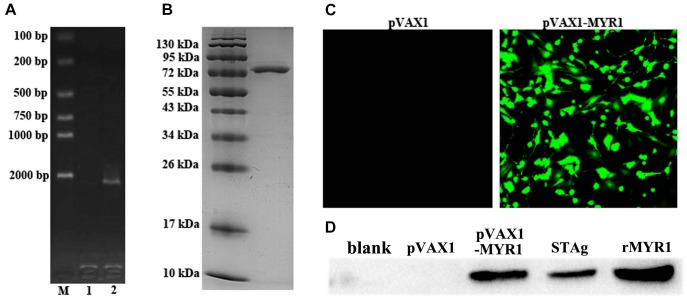
Expression of pET-28a-MYR1 in E. coli BL21 (DE3) and pVAX1-MYR1 in HEK293 cells. (A) Agarose gel analysis of the PCR-amplified myr1 gene. M: Marker, 1: Blank control, 2: T. gondii CDS. (B) SDS-PAGE of recombinant MYR1 protein after purification by Ni-NTA. (C) Immunofluorescence analysis of the expression of pVAX1-MYR1 in HEK293 cells. (D) Western blotting was used to detect the expression of MYR1 in HEK293 cells and STAg. Blank, non-transfected cells; pVAX1, empty pVAX1 transfected cells; pVAX1-MYR1, pVAX1-MYR1-transfected cells; STAg, soluble antigen of T. gondii; rMYR1, positive control.